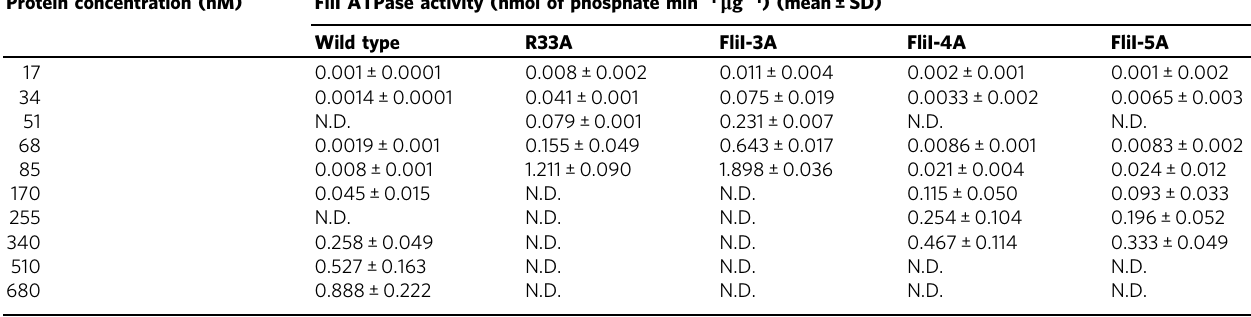
Table 1 ATPase activity of FliI mutants. Protein concentration (nM)